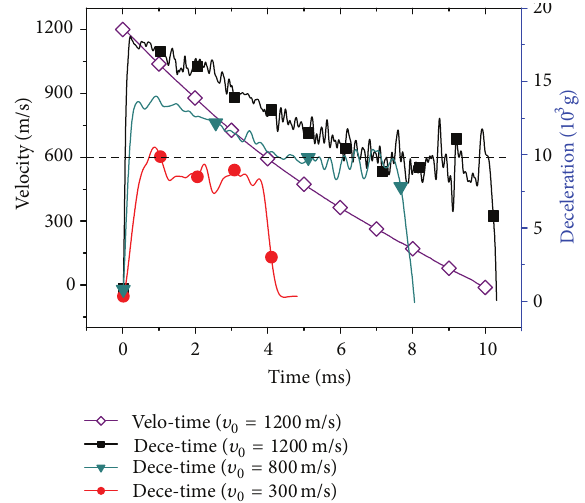
Figure 4: Deceleration & velocity versus time (40MPa concrete, TCK